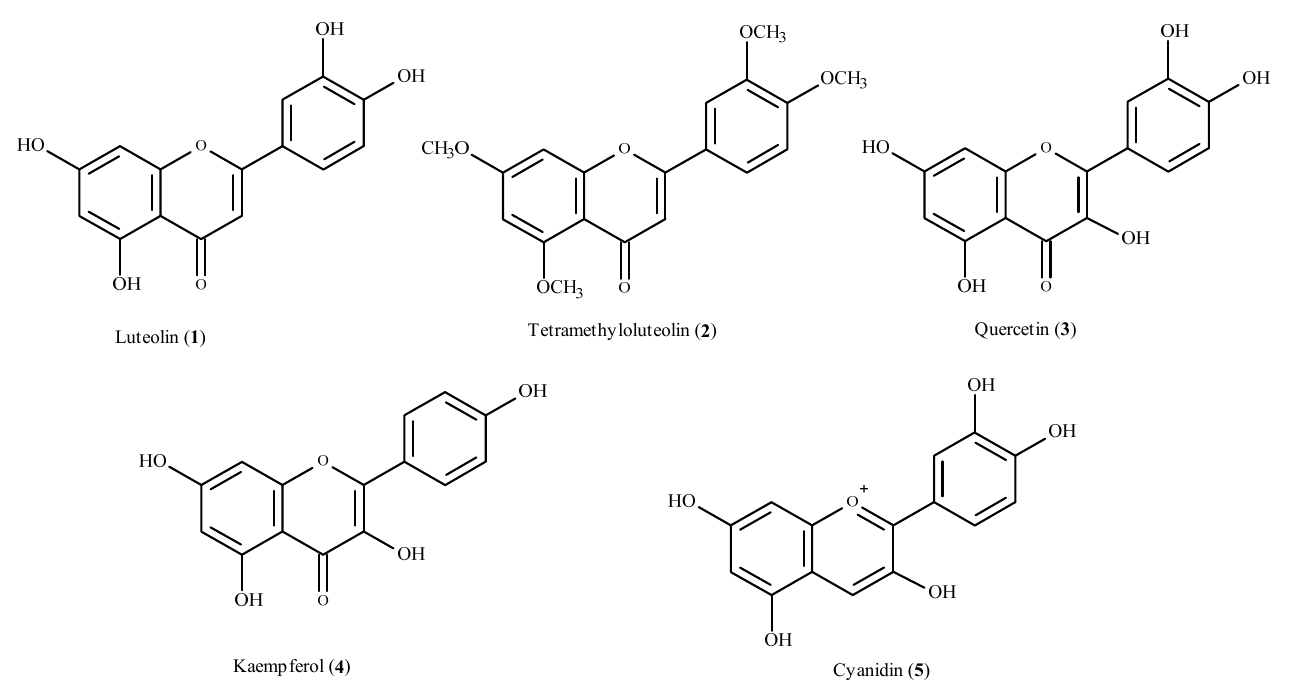
Figure 1. Structures of flavonoids mentioned in Section 5.1 with numbering.